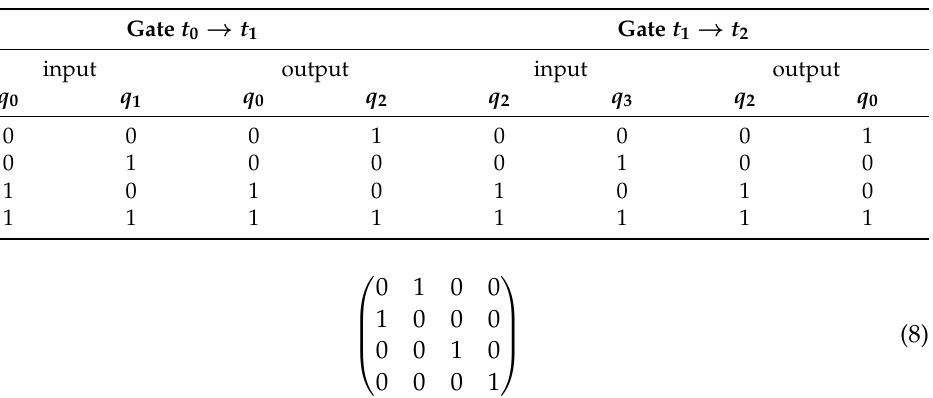
Table 1. Truth tables (reversible equivalents of XNOR gates), representing the interaction